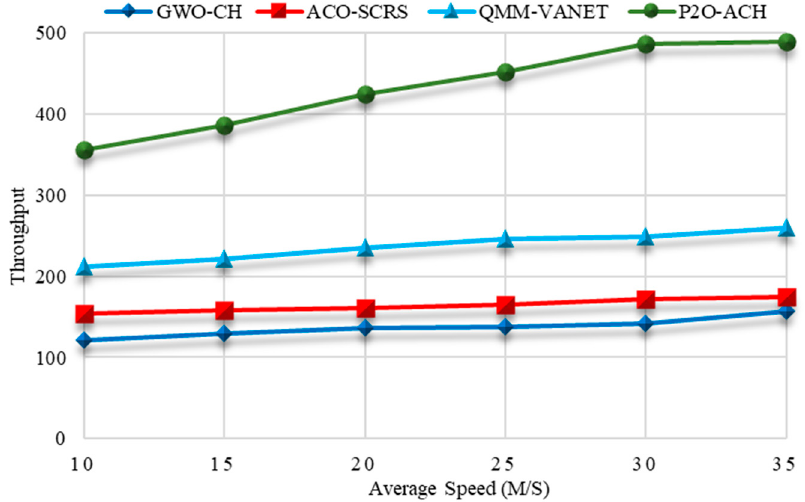
Figure 17. Network Throughput Calculation.